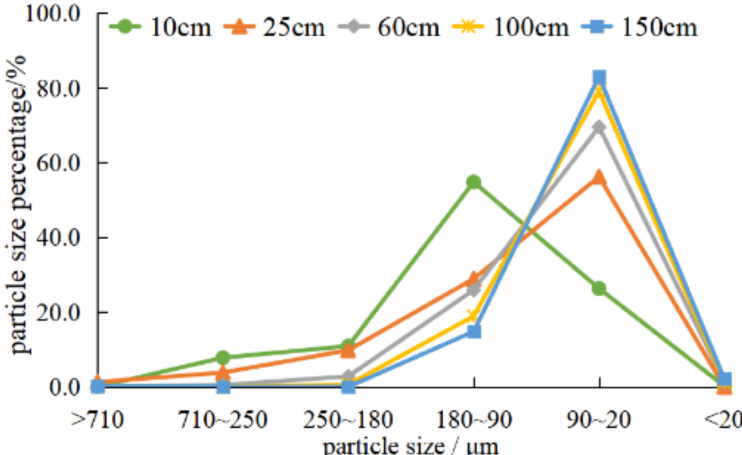
Figure 13. Huairou traditional tillage.